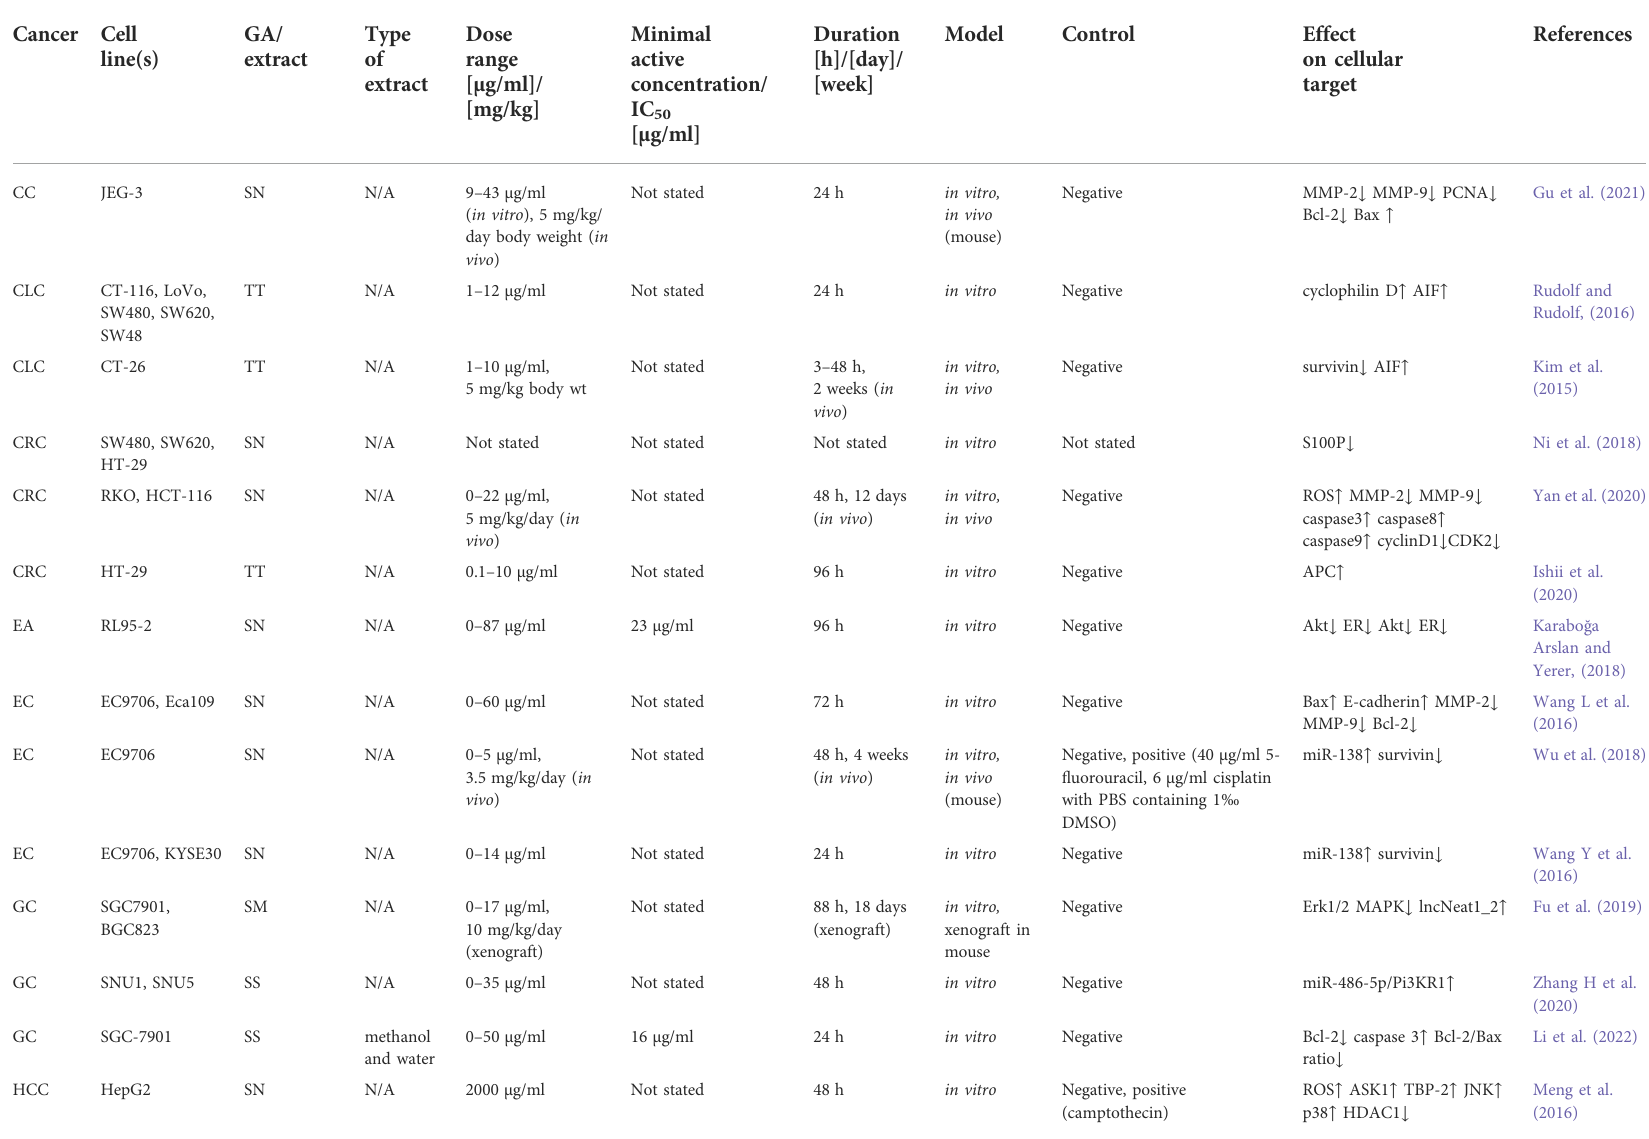
TABLE 1 ( Continued ) Effect of GAs on cellular targets in cancer